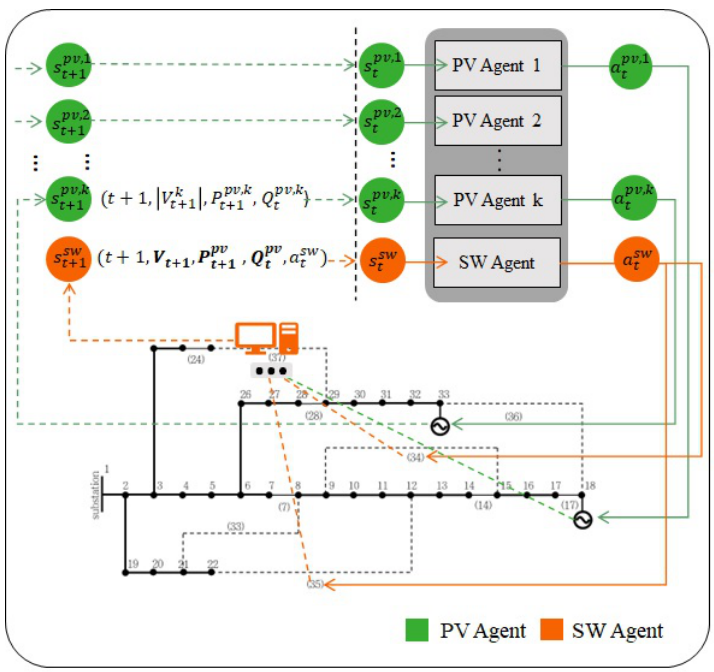
Figure 2. A framework of the proposed HMA-DRL